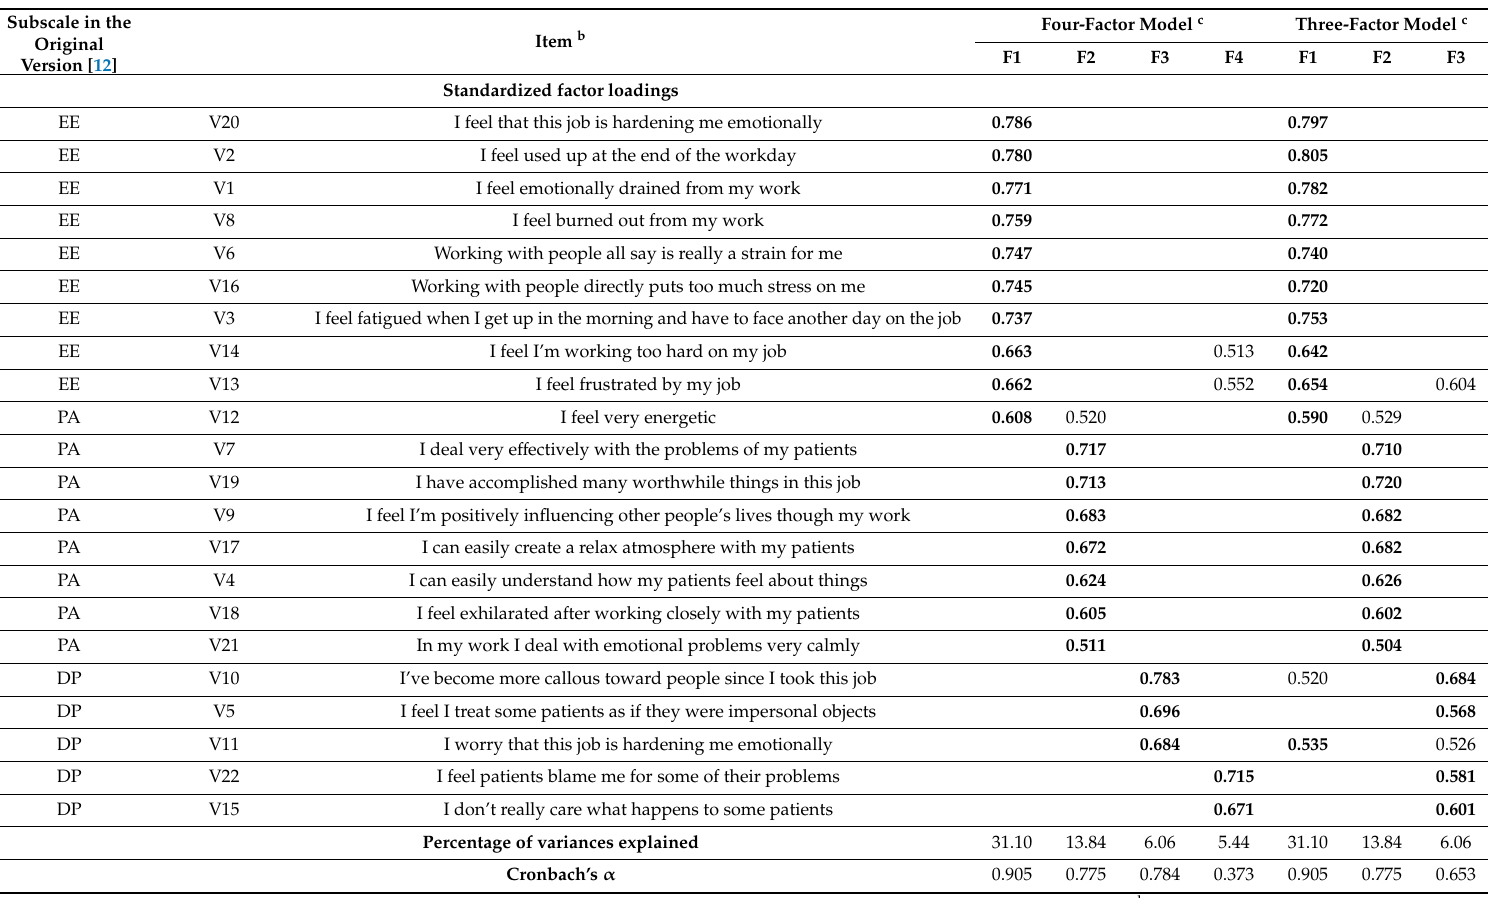
Table 3. Results of the exploratory factor analysis a of the Maslach burnout inventory obtained from the randomly selected subgroup 1 of the entire sample ( N = 190). Subscale in the